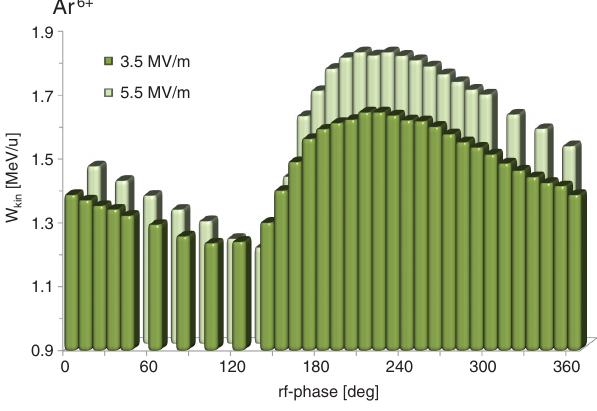
FIG. 14. Phase scan of Ar 6 þ -beam energy for 3 . 5 MV/m and 5 . 5 MV/m.